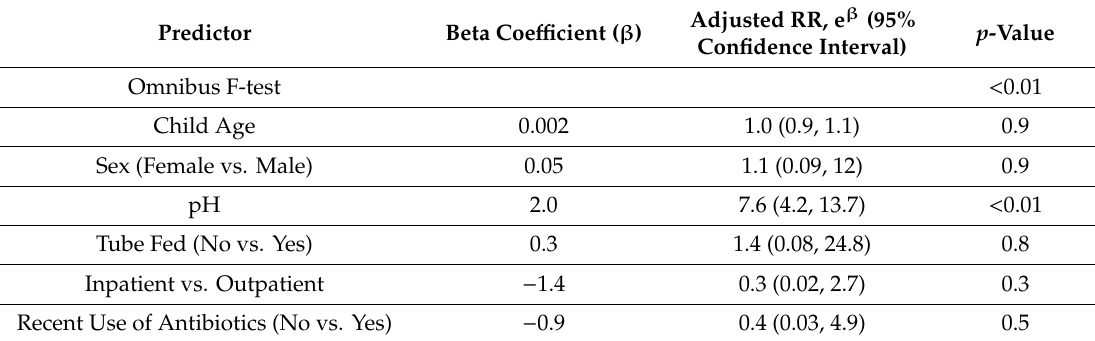
Table 2. Predictors of Total Bacterial Colonization.